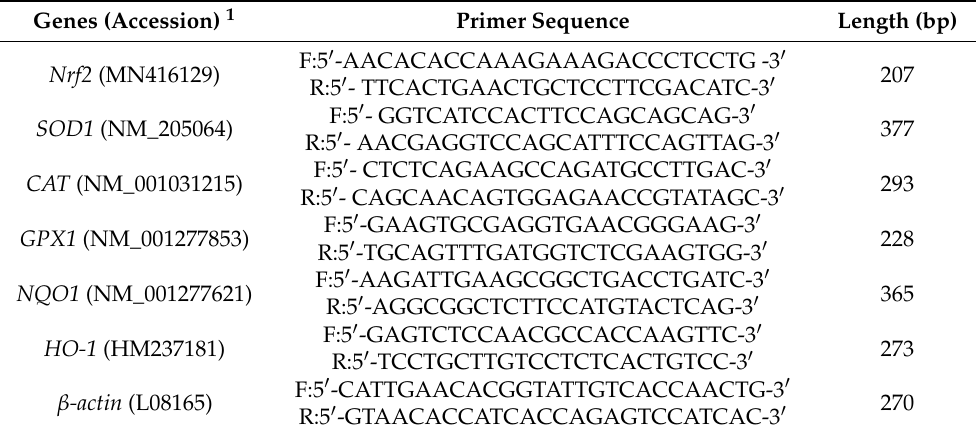
Table 2. Primer sequences for quantitative RT-PCR analysis.